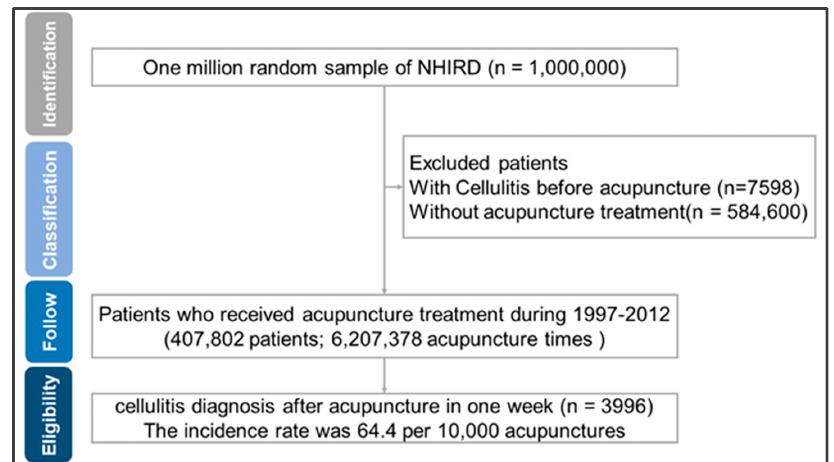
Figure 1. Flowchart of the recruitment of patients with cellulitis after acupuncture. We enrolled 407,802 patients with 6,207,378 acupuncture treatments and recorded 3996 cases of cellulitis that resulted in hospitalization and treatment with antibiotics form the National Health Insurance Research Database (NHIRD). Abbreviations: NHIRD, National Health Insurance Research